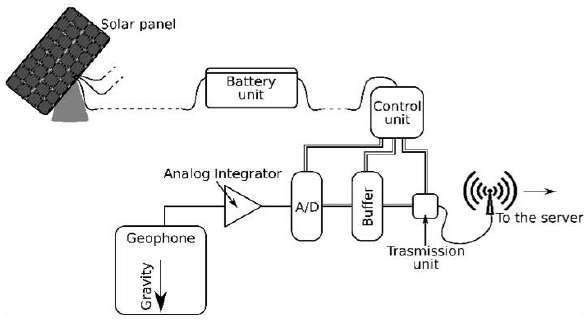
Figure 9. Block scheme of geophone sensor.